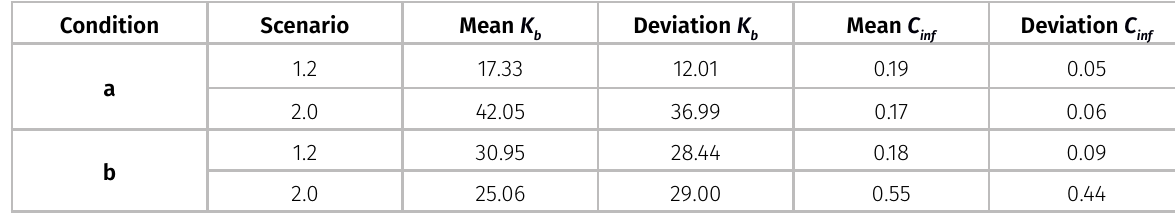
Table III. Mean and standard deviation for K exclusion criteria suggested by Horn (2016); and (b) including all preselected